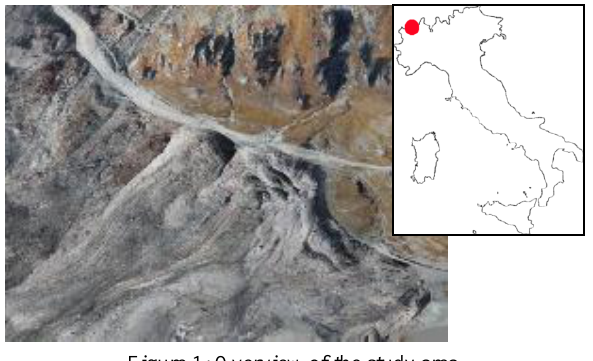
Figure 1: Overview of the study area.